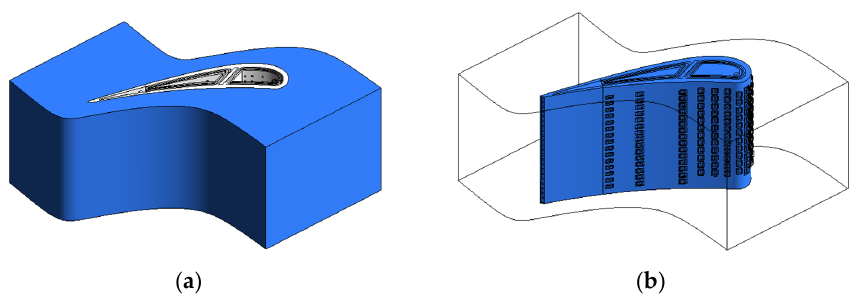
Figure 1. Domain division: ( a ) Domain 1; ( b ) Domain 2.